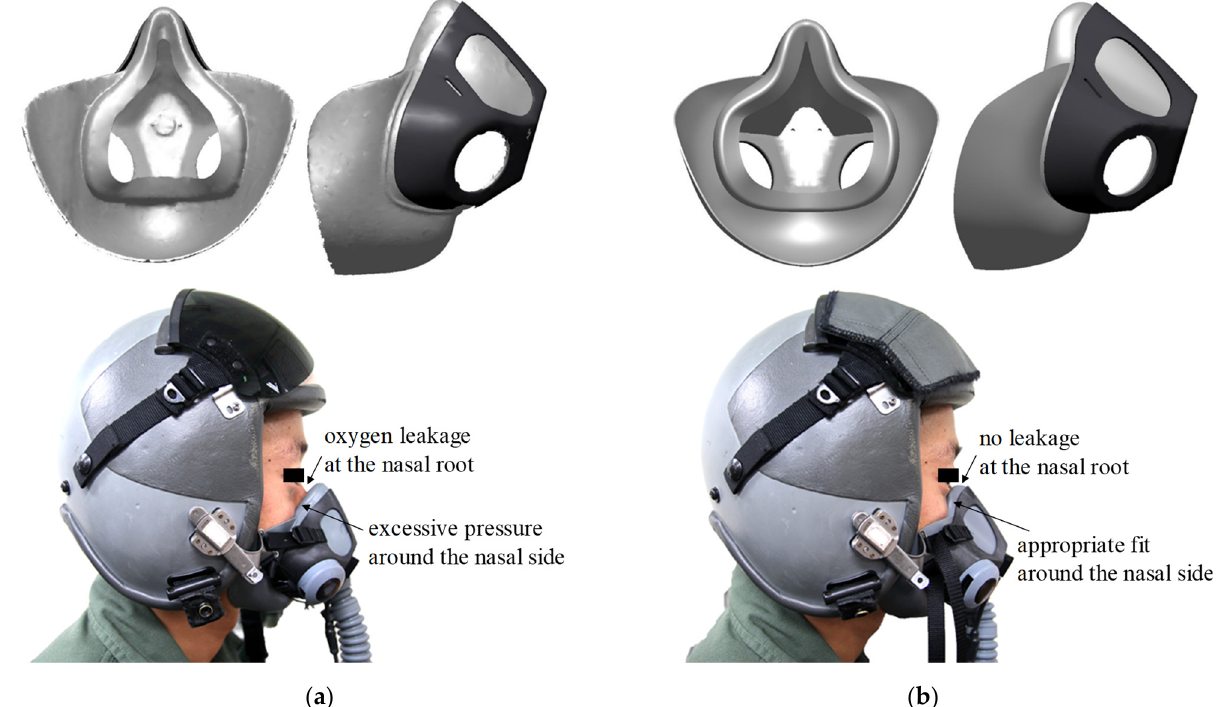
Figure 12. Visual comparison of existing and revised pilot oxygen masks. ( a ) MBU-20/P oxygen mask; ( b ) revised oxygen mask.